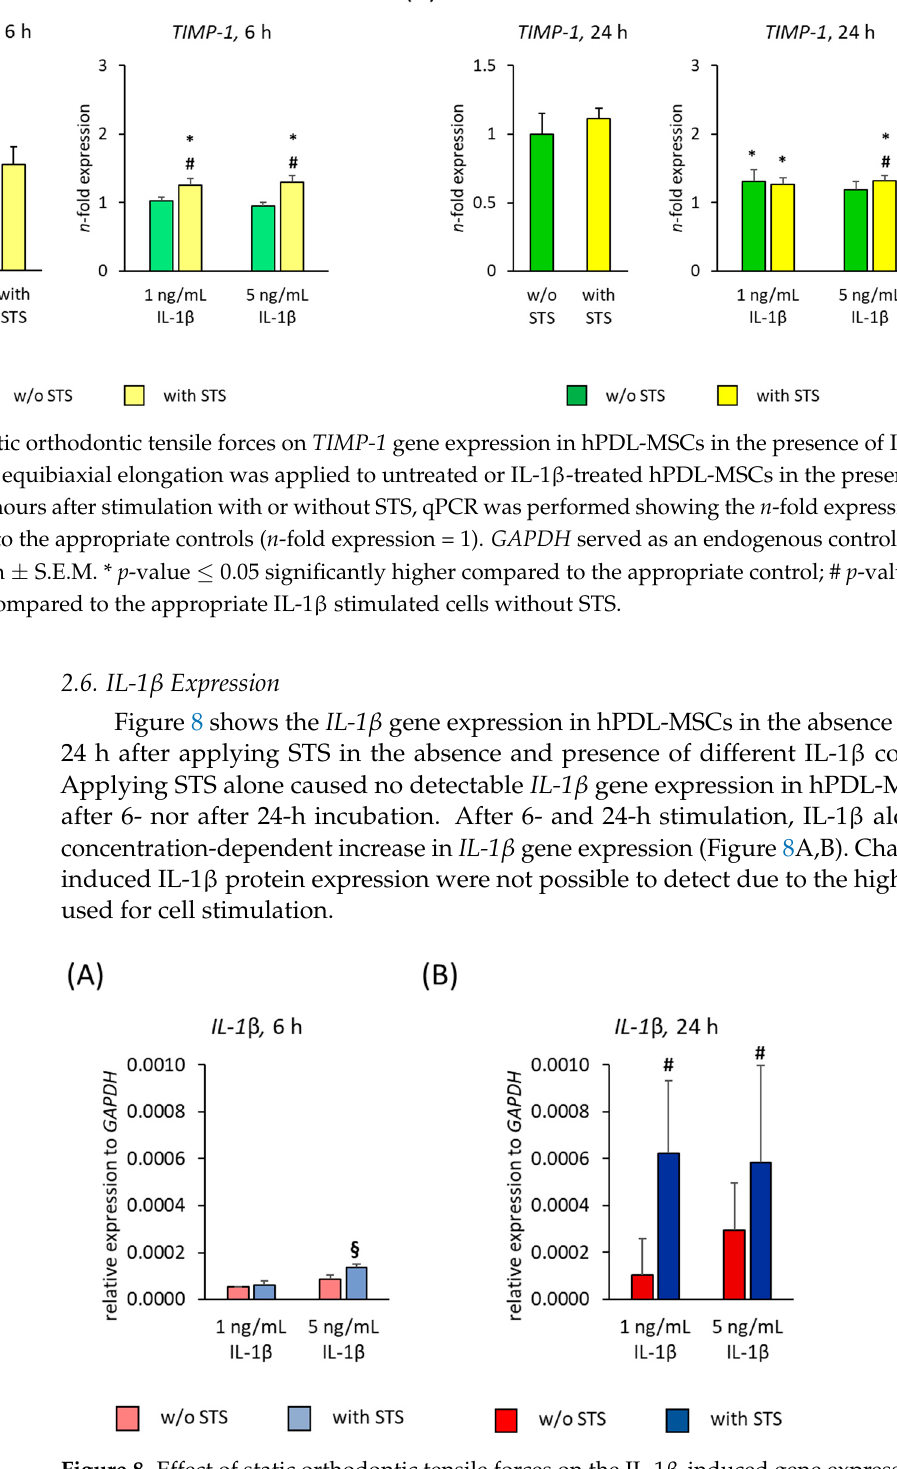
Figure 8. Effect of static orthodontic tensile forces on the IL-1 β -induced gene expression of IL-1 β in hPDL-MSCs in the absence of FBS. STS with 6% equibiaxial elongation was applied to untreated or IL-1 β -treated hPDL-MSCs in the absence of FBS. 6 ( A ) and 24 ( B ) hours after stimulation with or without STS, qPCR was performed showing the relative IL-1 β expression levels normalized to the internal reference gene GAPDH . All data are presented as mean ± S.E.M. # p -value ≤ 0.05 significantly higher compared to the appropriate IL-1 β stimulated cells without STS; § p -value ≤ 0.05 significantly higher compared to 1 ng/mL IL-1 β in the presence of